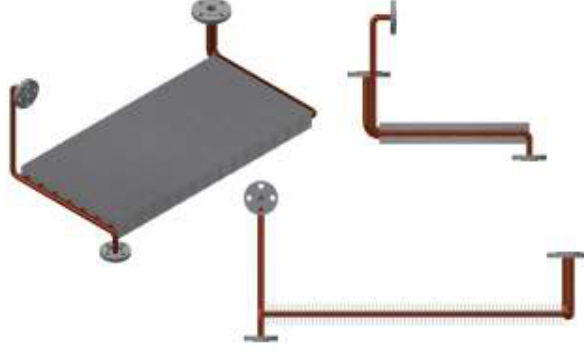
Fig. 5. The structural design of the evaporator.